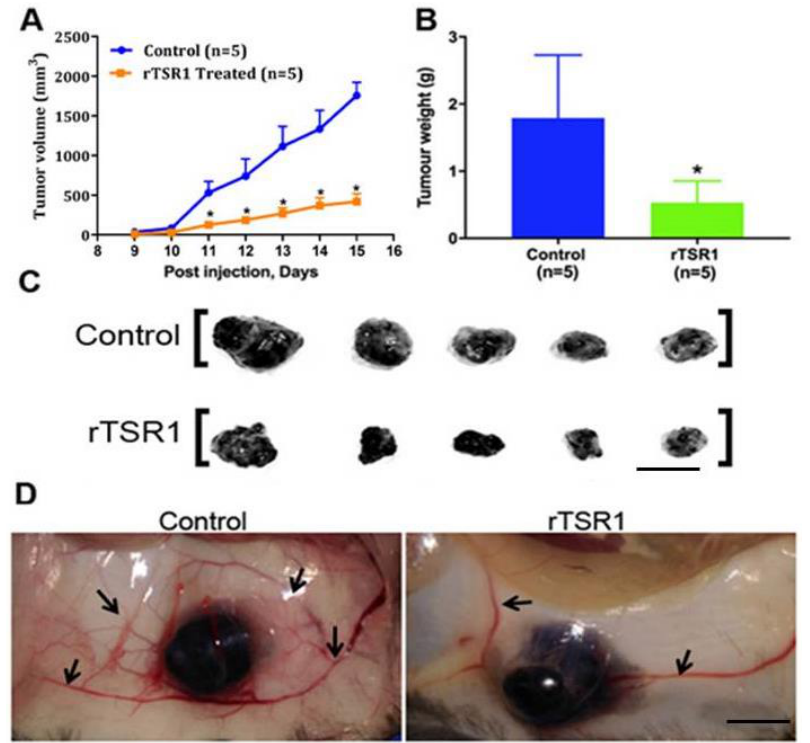
Figure 2. Systemically delivered rTSR1 suppressed B16F10 tumor growth in mice. ( A ) Tumor growth curve from day 9 to 15 post tumor cell injection ( n = 5). Data represents mean ± SD. The rTSR1 was systemically delivered through intra-peritoneal (IP) injection. Statistical analysis performed by Student’s t test. * p < 0.05; ( B ) Tumor weight at the end of experiment, control and rTSR1 treated group, n = 5 for each group. The graph represents the mean ± SD of the tumor weight. Statistical analysis performed by Student’s t test. * p < 0.05; ( C ) Dissected tumor nodules from control and rTSR1 treated groups—scale bar: 1 cm; ( D ) rTSR1-treated mice showed a reduced peri-tumor vascular network compared to tumors of similar sizes in the control group—scale bar: 0.5 cm. Arrows indicate the blood vessels surrounding the tumor.